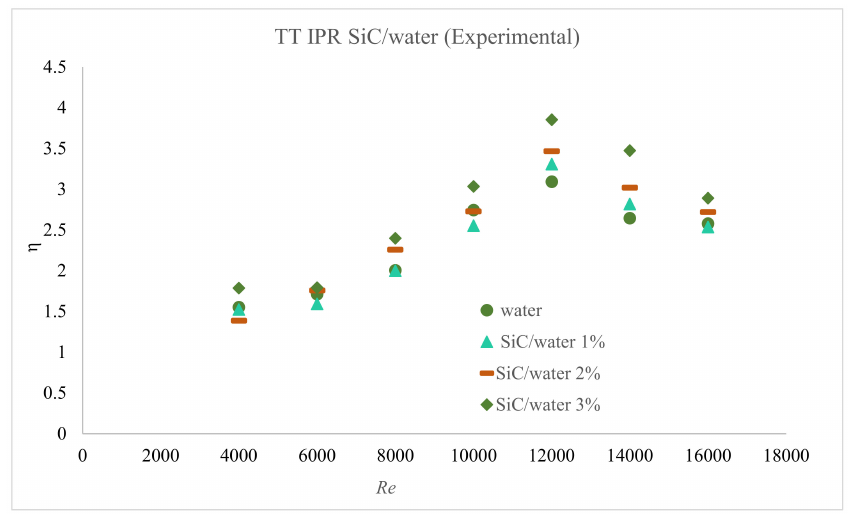
Figure 28. E ff ect of the nanofluid volume fraction ϕ on η (Numerical).